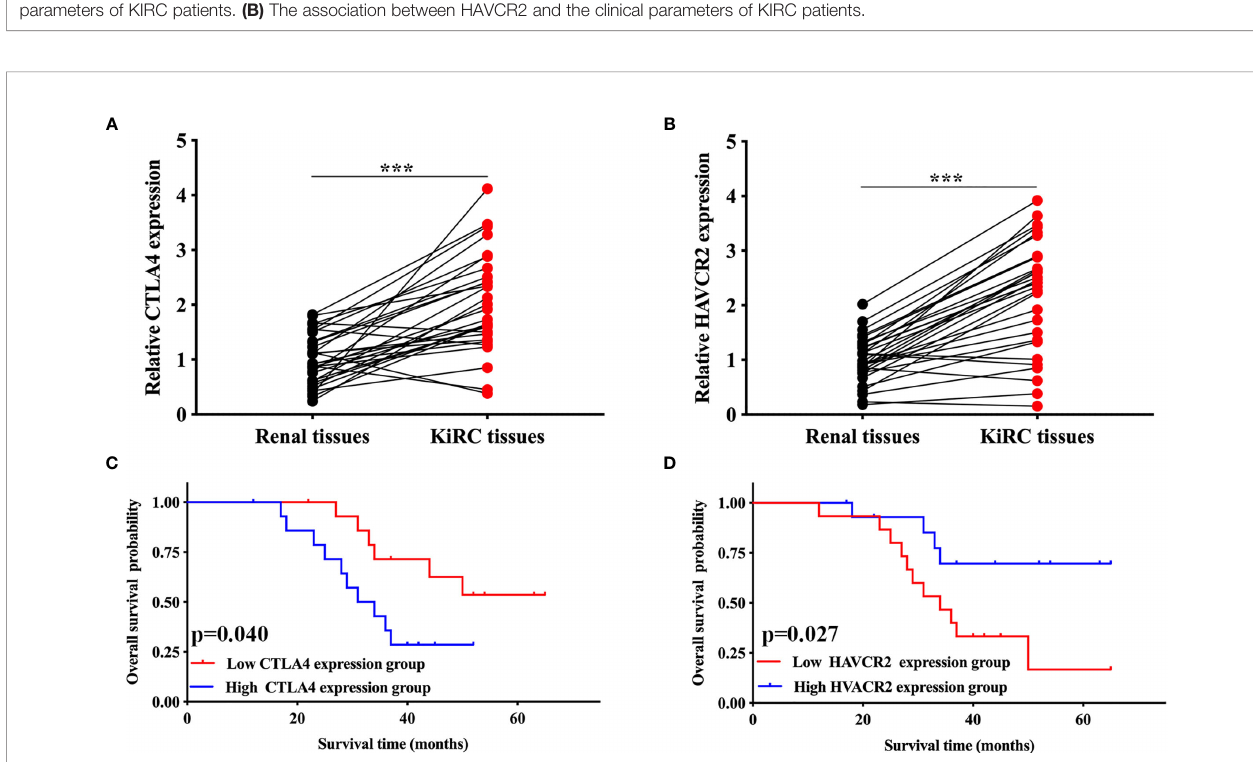
FIGURE 6 | Validation of the expression and overall survival of CTLA4/HAVCR2 in KIRC. (A, B) The expression of CTLA4/HAVCR2 in KIRC and normal renal tissues. (C, D) The overall survival curve of CTLA4/HAVCR2 in KIRC patients in high and low expression cohort. ***p <